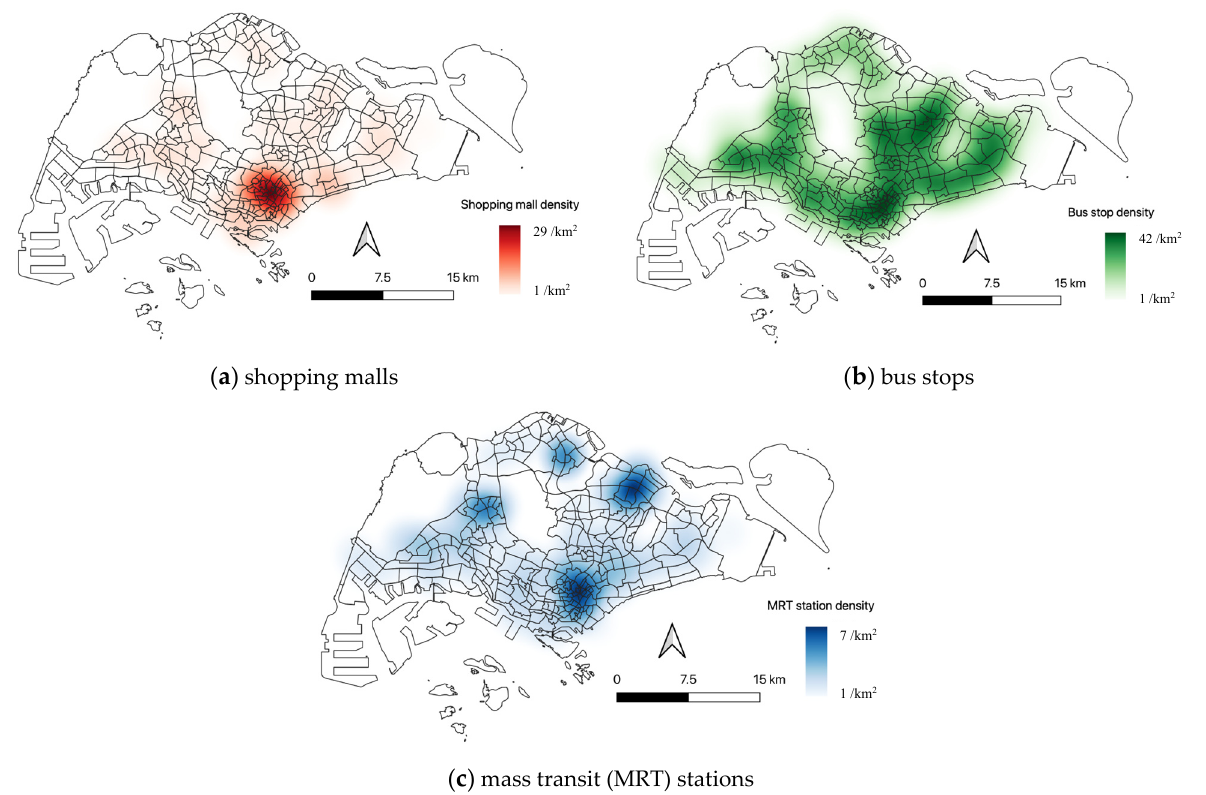
Figure 1. Spatial density of shopping malls, bus stops, and mass transit (MRT) stations in Singapore.